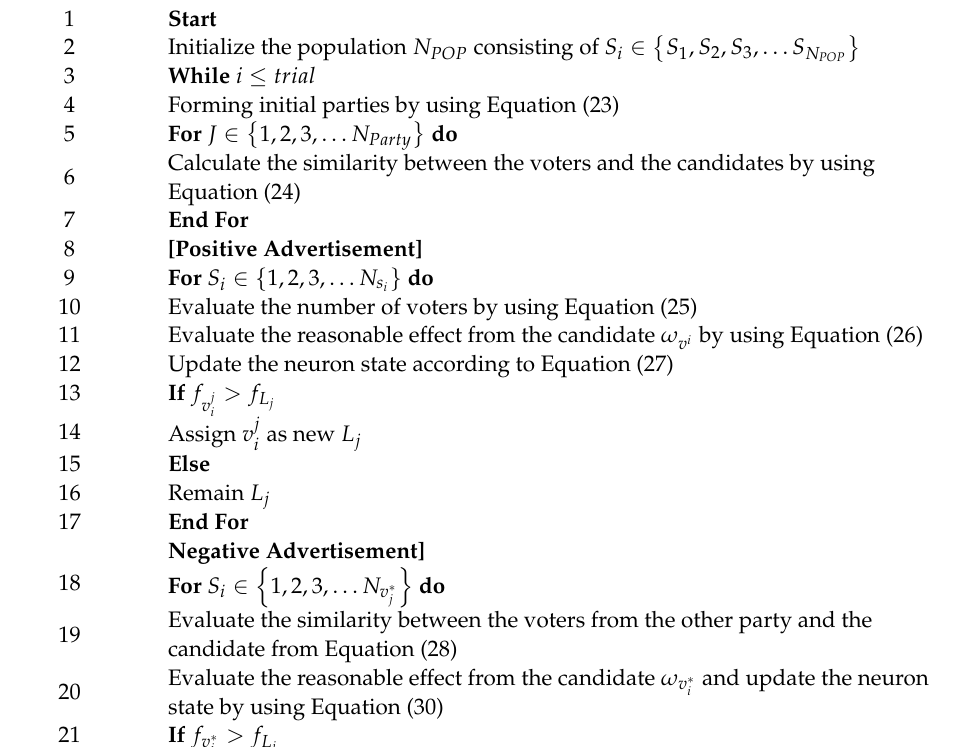
Algorithm 2 Pseudocode for proposed Hybrid Election